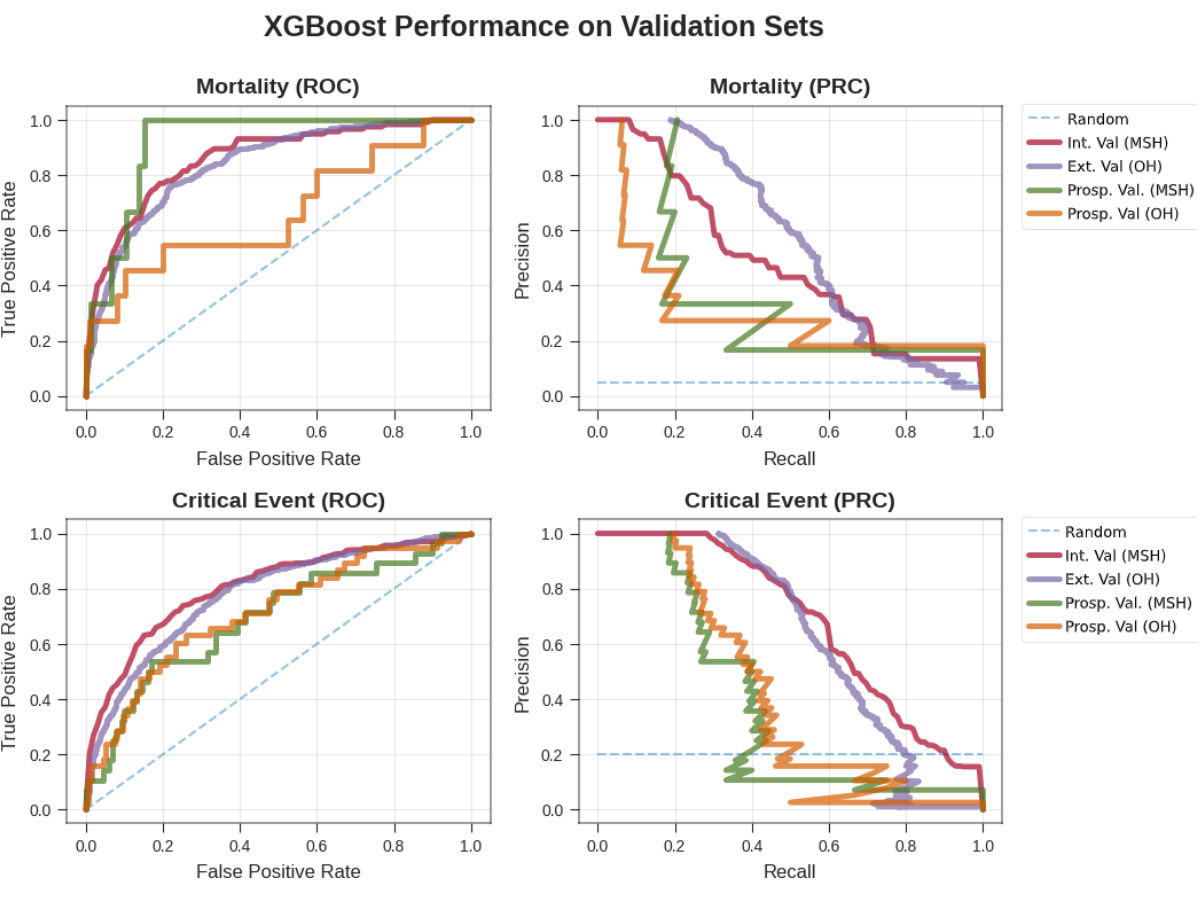
Figure 3. Performance of the XGBoost classifier by ROC curves (left) and precision-recall curves (right) for mortality (top) and critical events (bottom) in validation experiments of generalizability and time. For generalizability, we show our XGBoost model from cross-validation on MSH and applied to all other hospitals. We also show the performance of the model on prospective patients who were unseen at the time of the original experiment at MSH and all other hospitals in the same time frame. Ext. Val.: external validation; Int. Val.: internal validation; MSH: Mount Sinai Hospital; OH: